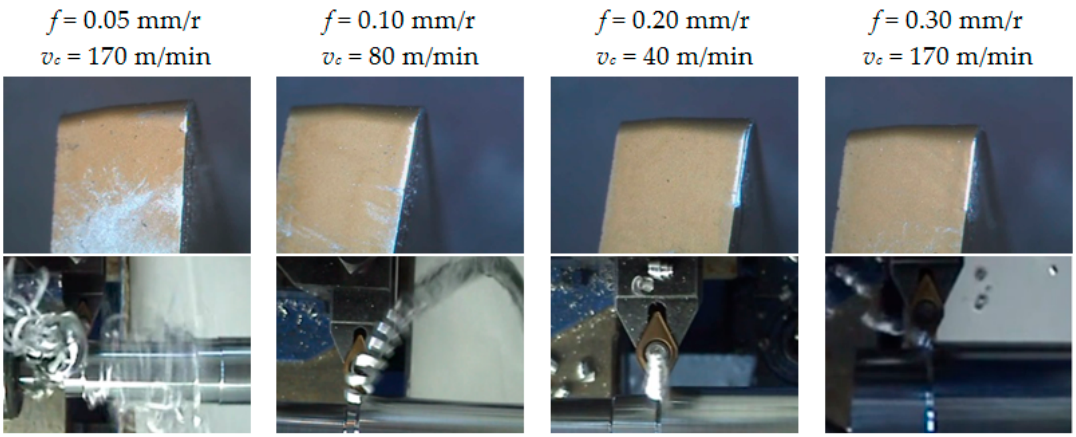
Figure 7. SOM images (20×) of the flank face and captured images of the chip, for a p = 2